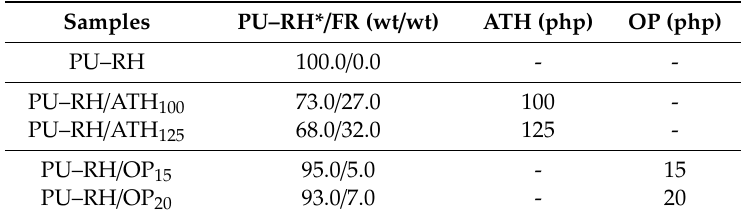
Table 1. Main formulations by wt / wt and php of rice husk-reinforced polyurethane (PU–RH) samples with and without flame retardants